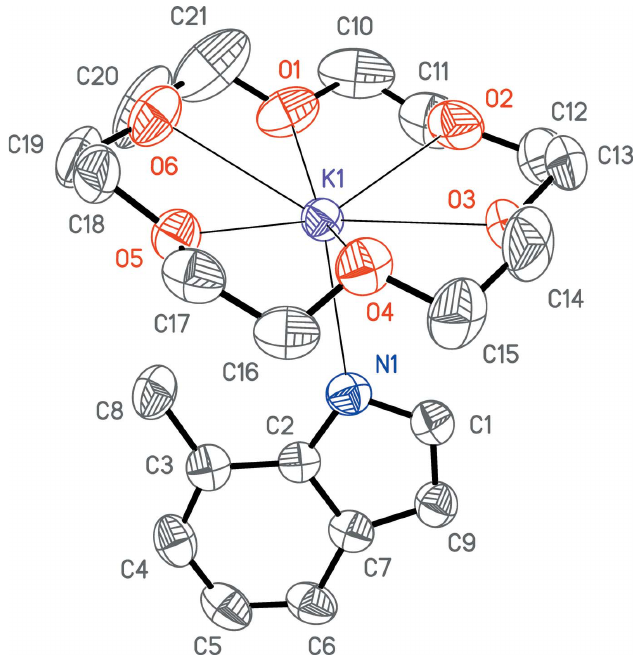
Figure 4 Anisotropic displacement ellipsoid plot of 3 drawn at the 50% probability level with H atoms and the minor component of disorder